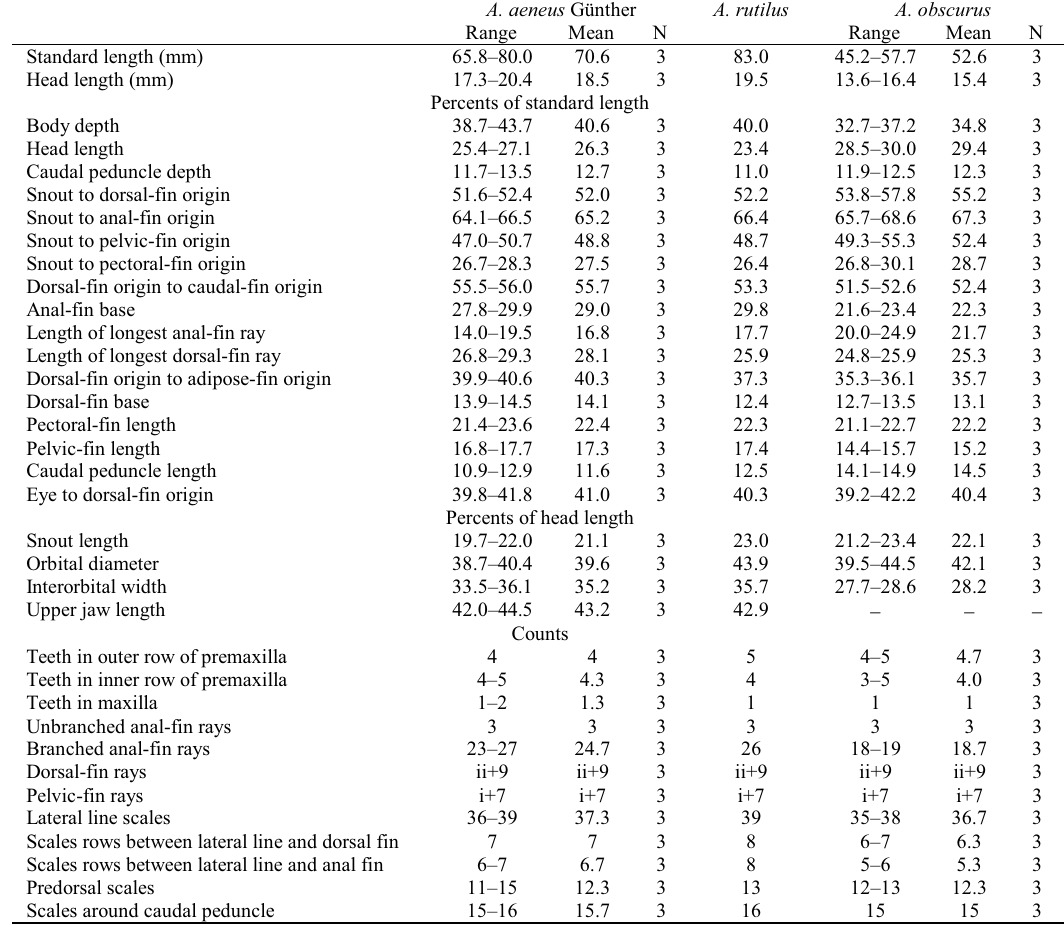
Table 2 . Morphometric and meristic data of the syntypes of A. aeneus (Günther, 1860), BMNH 1860.6.17.41-2, BMNH 1907.4.10.3, and A. obscurus (Hensel, 1870), ZMB 7478, and the holotype of Astyanax rutilus (Jenyns, 1842), BMNH